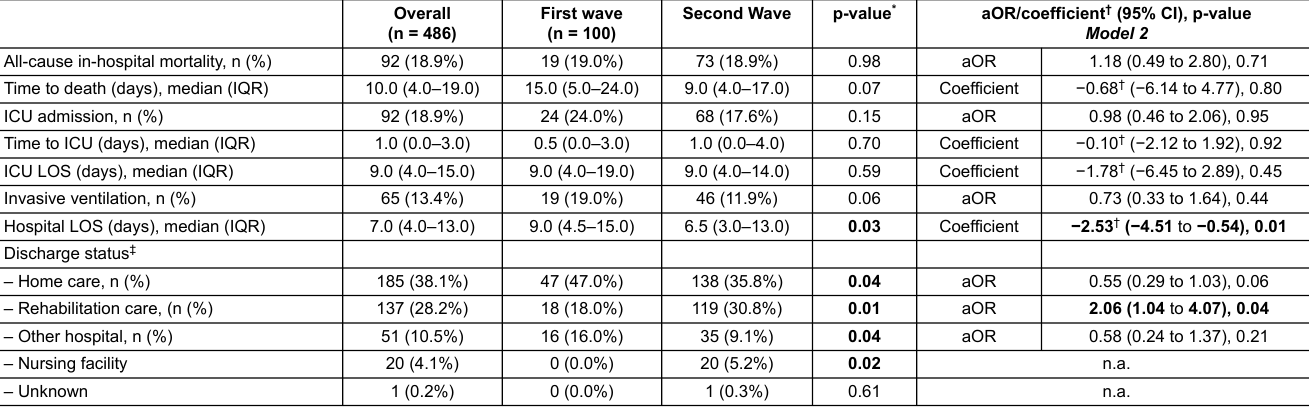
Table 2: Outcomes overall and stratified by wave. Odds ratios and regression coefficients for wave (base = first wave).